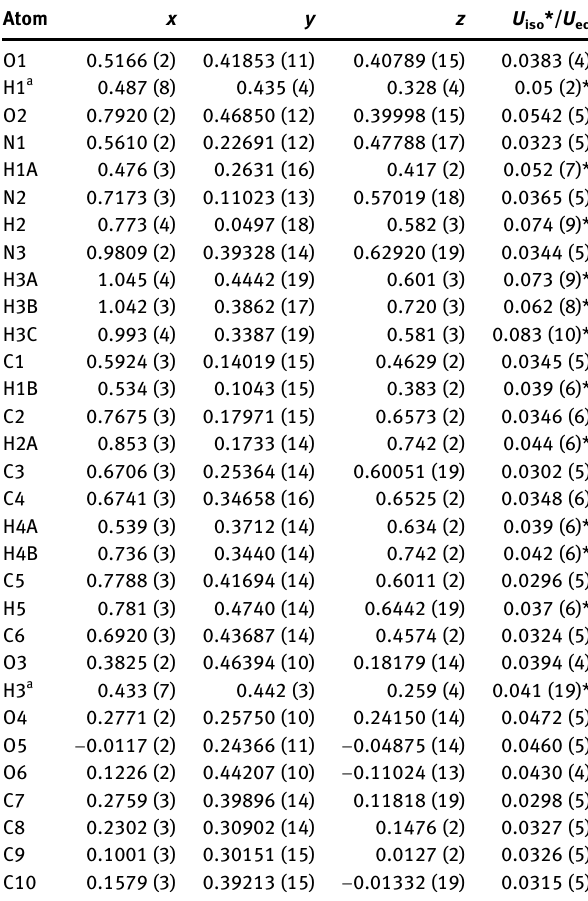
Table  : Fractional atomic coordinates and isotropic or equivalent isotropic displacement parameters (Å 